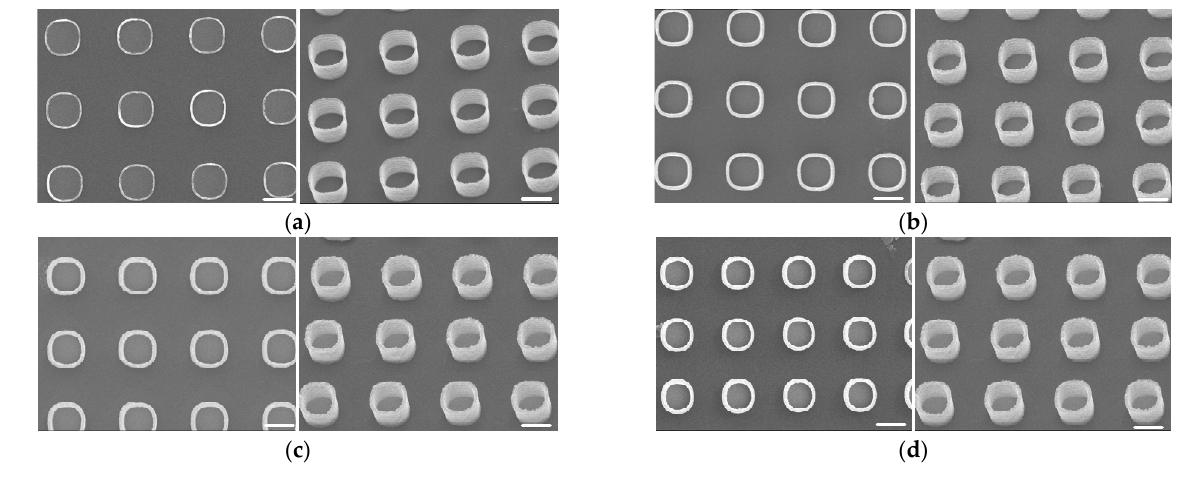
Figure 3. Top ‐ and tilted ‐ view FESEM images of PMAA arrays after AgC attachment using ( a ) 3, ( b ) Figure 3. Top- and tilted-view FESEM images of PMAA arrays after AgC attachment using ( a ) 3, 6, ( c ) 9, and ( d ) 12 cycles of the “breathing ‐ in” processes. Scale bars equal 500 nm. ( b ) 6, ( c ) 9, and ( d ) 12 cycles of the “breathing-in” processes. Scale bars equal 500